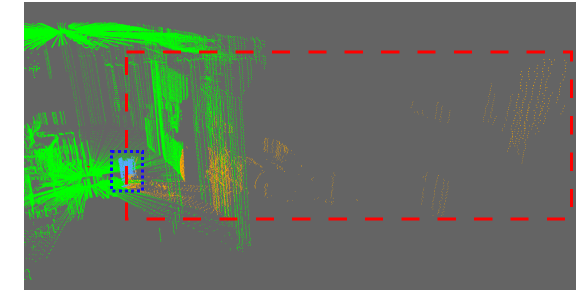
Figure 10: Points on the identified mirror planes are turqoise and corrupted points behind the mirror planes are orange.